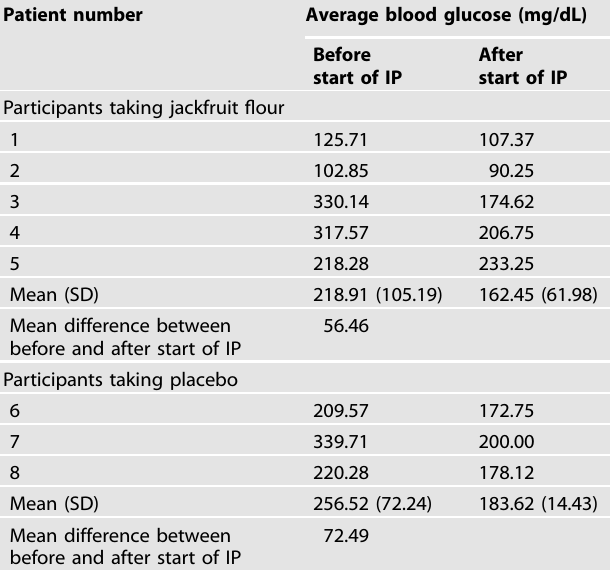
Table 4. Average blood glucose level in continuous glucose